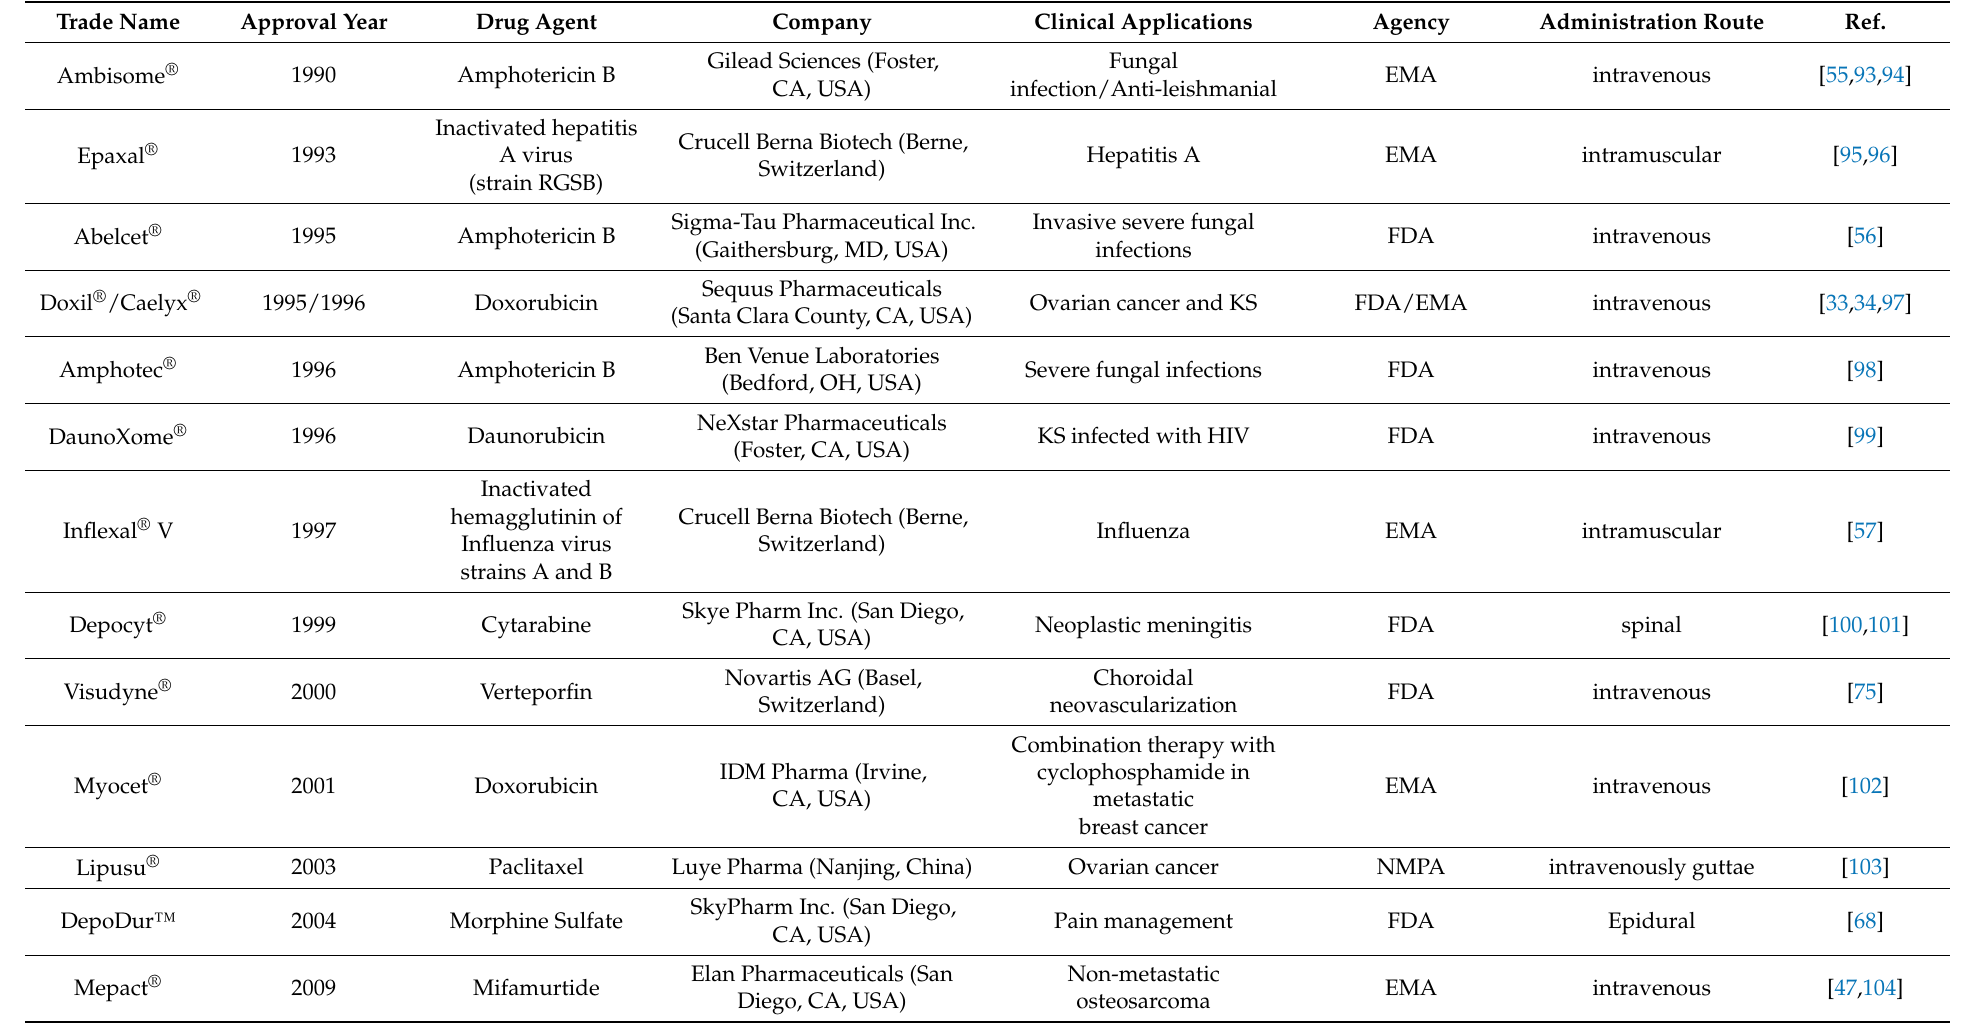
Table 1. Marketed liposome- and LNP